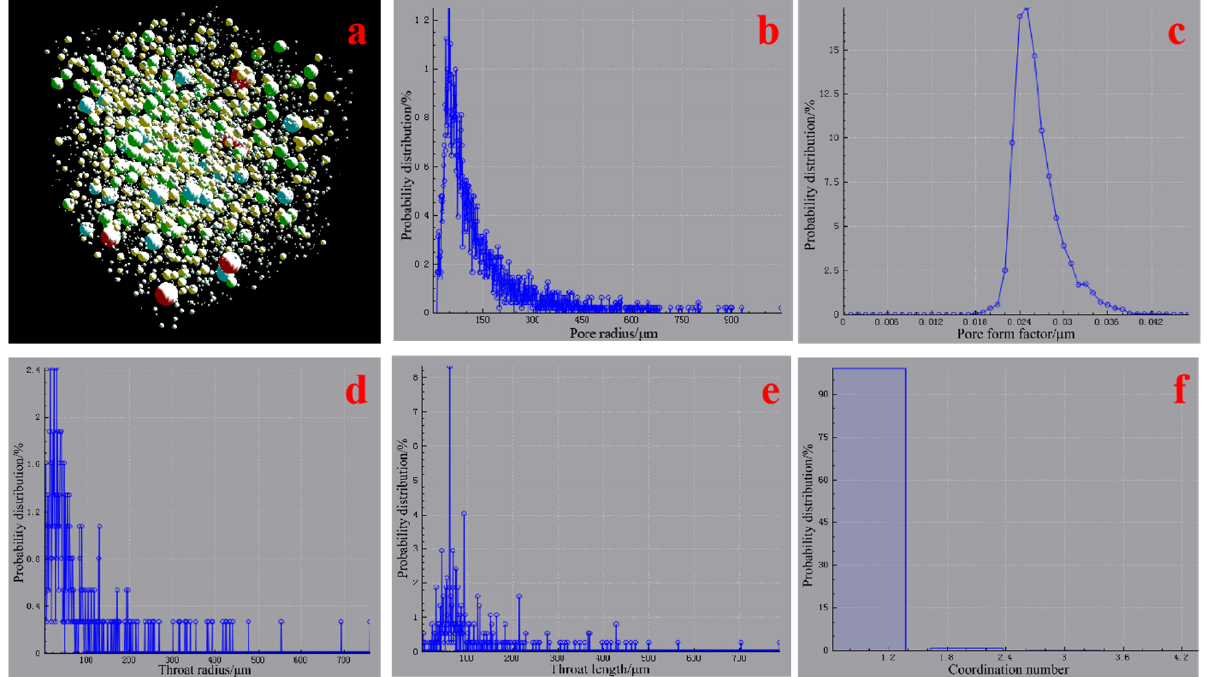
Figure 12. Characterization parameter analysis diagram of AACM specimen. (( a ): ball and stick model, ( b ): pore radius, ( c ): pore form factor, ( d ): throat radius, ( e ): throat length, and ( f ): coordina- tion number).